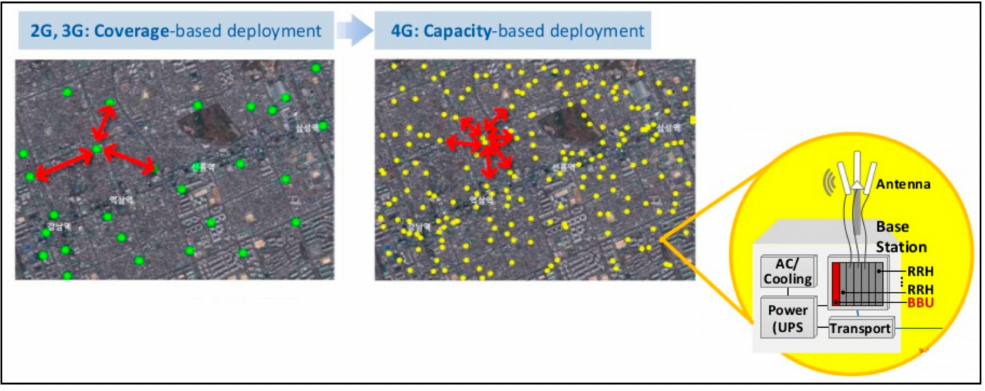
Figure 2. Realistic deployment of 2G, 3G, and 4G base stations (BSs)